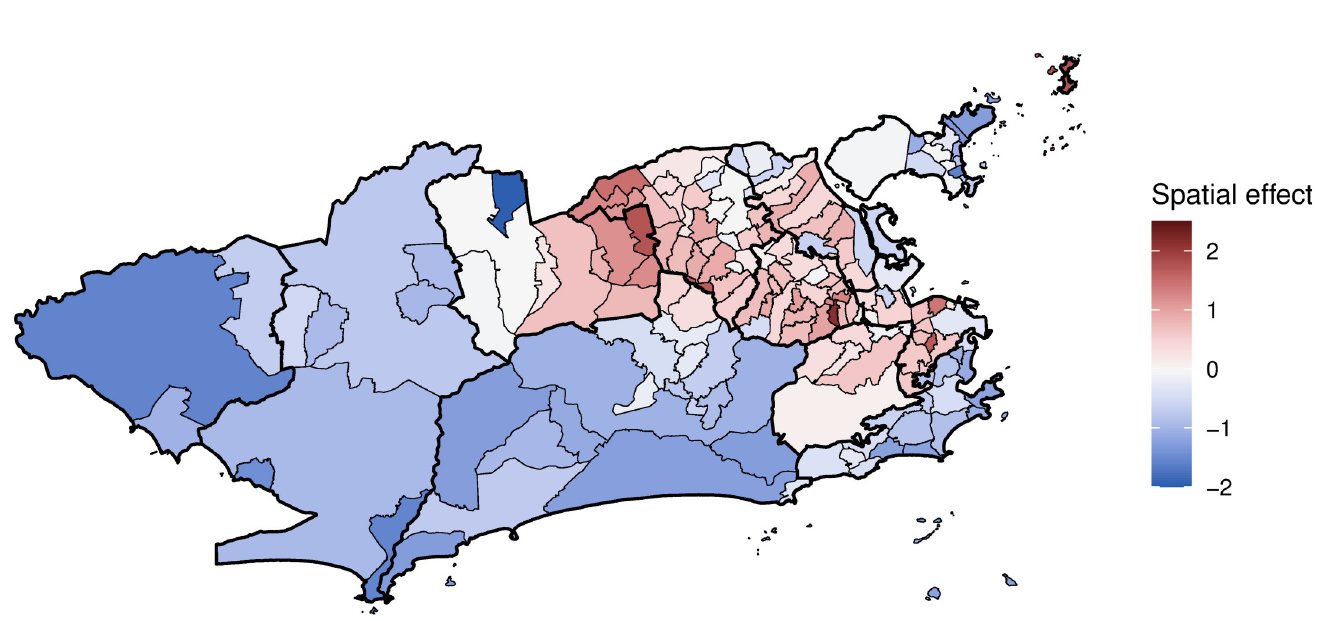
Fig 6. Chikungunya cases mean spatial effects (in the log scale) controlling for sociodevelopment index, proportion of green areas, and minimum temperature, weeks 9 to 52 2016, Rio de Janeiro city, Brazil. Map created using R version 3.6.1. Map layers by Instituto Pereira Passos (https://www.data.rio/).